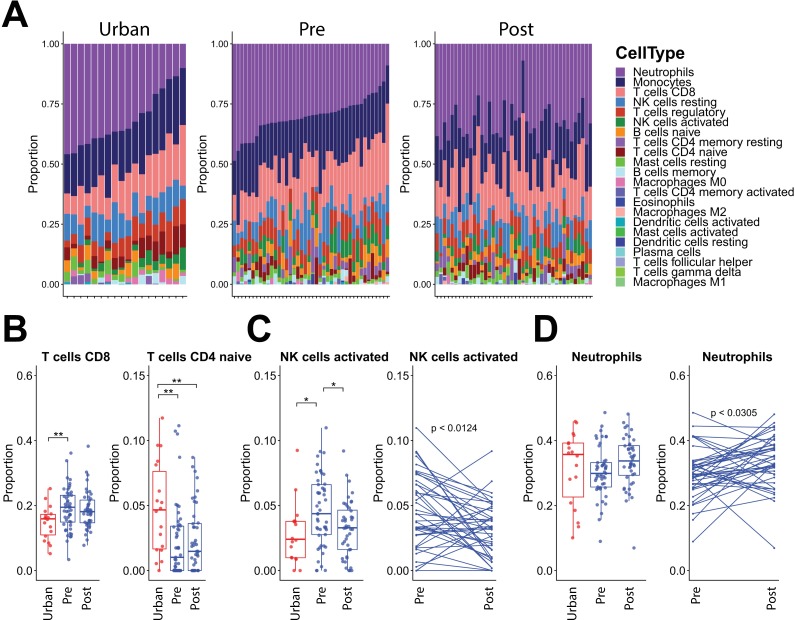
Immune cell type estimates from blood transcriptional profiles.(A) Immune cell type proportion estimates from default CIBERSORT [74] deconvolution of 22 cell types in urban, Orang Asli pre- and post-deworming blood transcriptional profiles. Matched samples from Orang Asli pre- and post-deworming are shown in the same order along the horizontal axes. (B) Significant differences between urban and Orang Asli, and before or after deworming, samples are shown for CD8+ T cells, naïve CD4+ T cells, (C) monocytes and (D) activated NK cells according to bootstrapped one-way ANOVA with 999 simulations and subsequent Tukey with multiple test correction. * = p≤0.05; ** = p≤0.01; *** = p≤0.001. Additional Wilcoxon tests indicate significant differences between matched villager before and after samples for (C) monocytes and (D) activated NK cells.